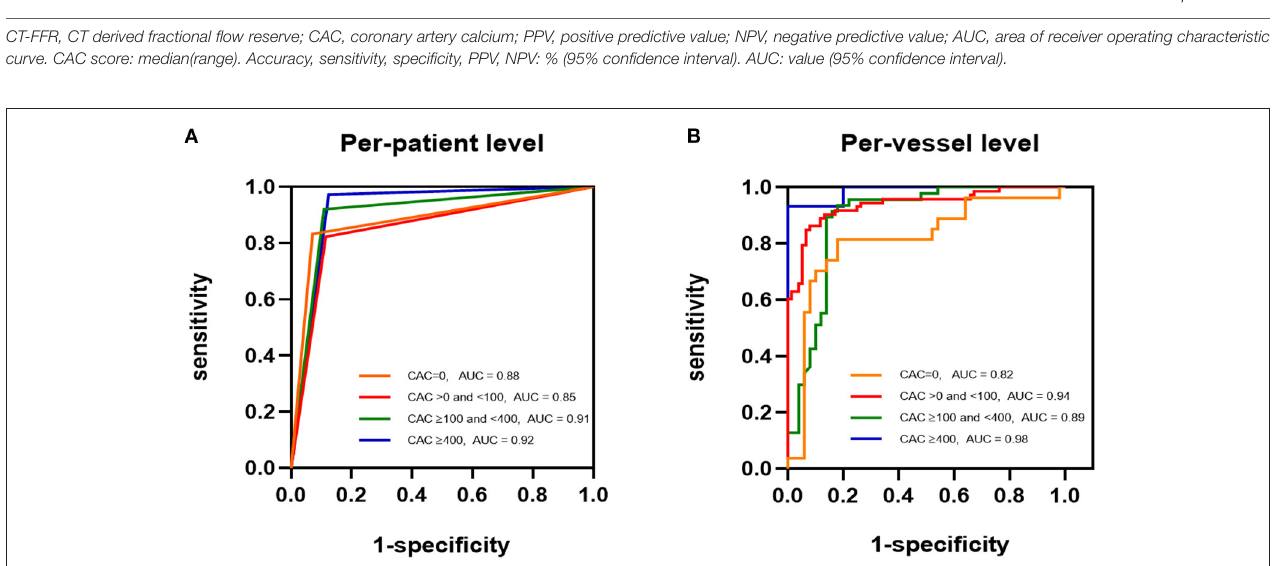
The Bland-Altman analysis revealed good consistency of FFR and CT-FFR values across all CAC score categories, which was acceptable ( Figure 3 ). And the bias was as following: − 0.01 (95% limits of agreement: − 0.03 to 0.03) for CAC = 0, 0.01 ( − 0.01 to 0.01) for CAC > 0 to < 100, 0.03 (0.01–0.06) for CAC ≥ 100 to < 400, 0.0 ( − 0.08–0.06) for CAC ≥ 400, respectively. Besides, the absolute difference of CT-FFR and FFR tended to elevate with increased CAC scores (CAC = 0: 0.09 ± 0.10; CAC > 0 to < 100: 0.06 ± 0.06; CAC ≥ 100 to < 400: 0.09 ± 0.10; CAC ≥ 400: 0.11 ± 0.13; p = 0.246), although no statistically significant difference was